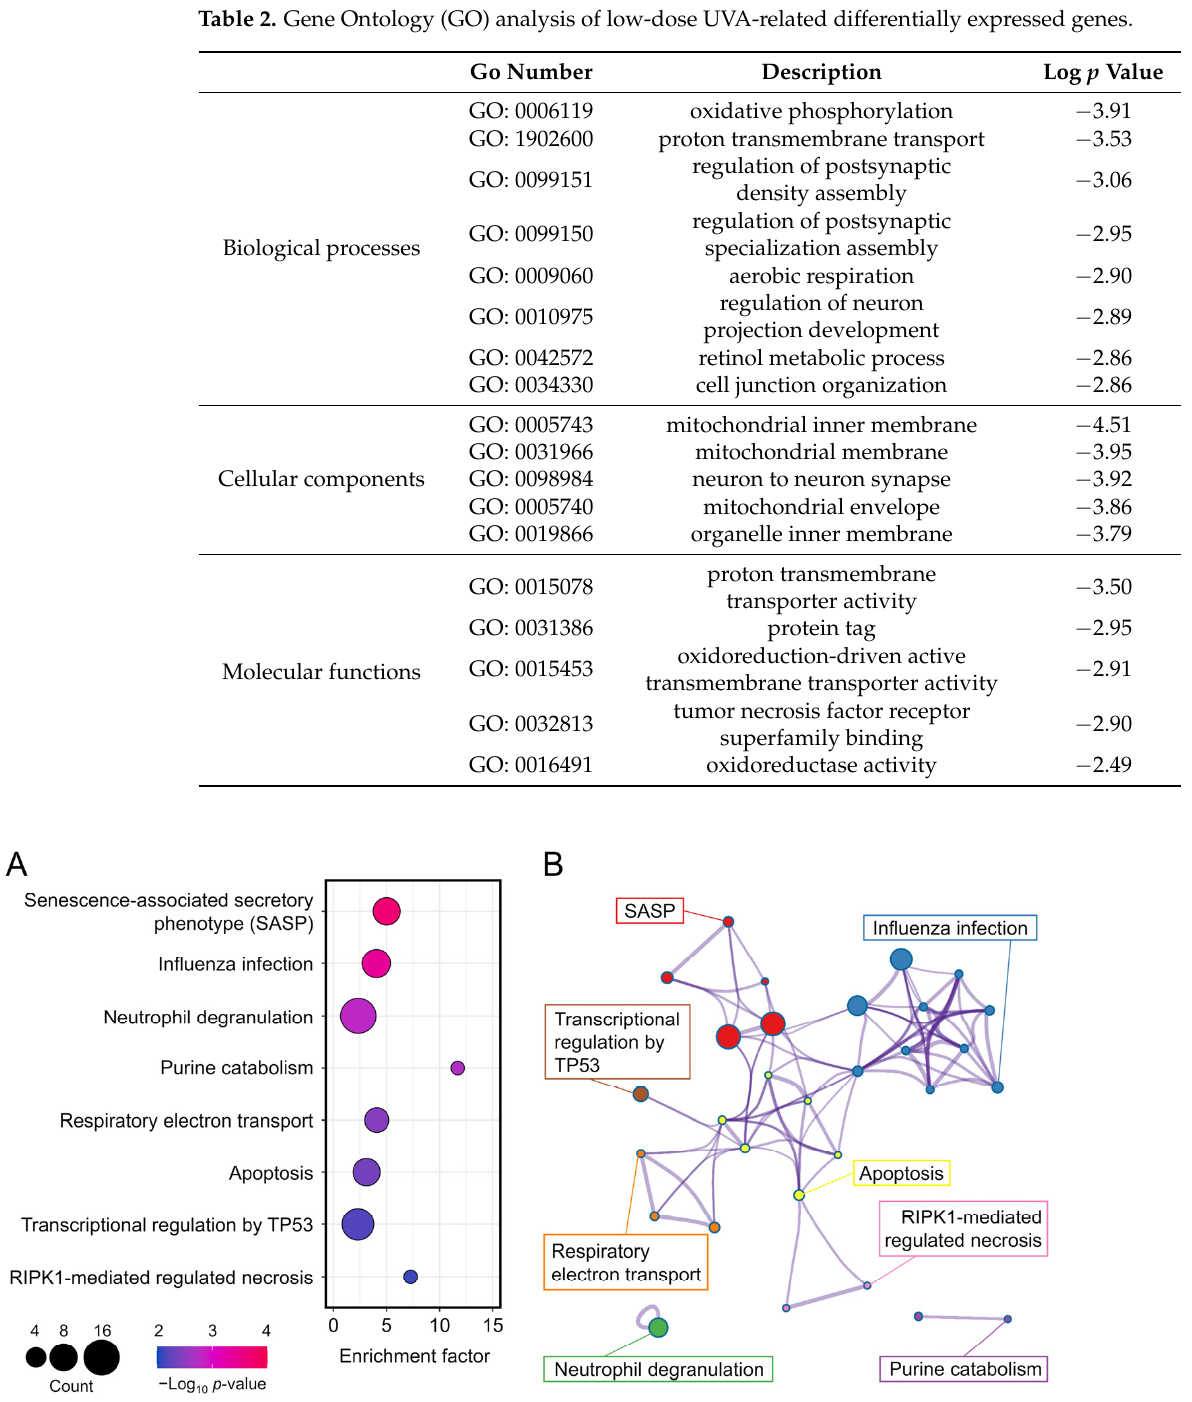
Figure 5. ( A ) Bubble diagram of top eight enriched reactomes. Bubble size indicates the number of differentially expressed genes. Bubble color indicates the p -value. ( B ) Cluster diagram of enriched pathways. Table 3. Reactome analysis of low-dose UVA-related differentially expressed genes.